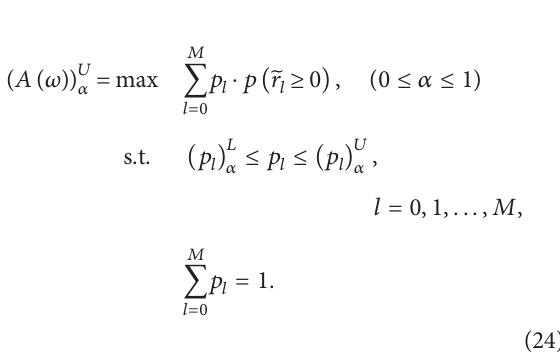
Figure 3: Fuzzy performance rate and fuzzy demand.